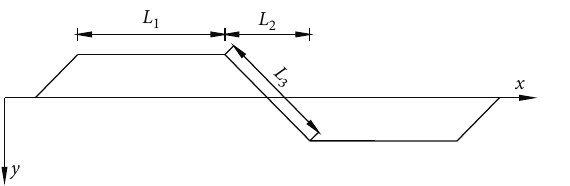
Figure 2: Geometry of the corrugated steel